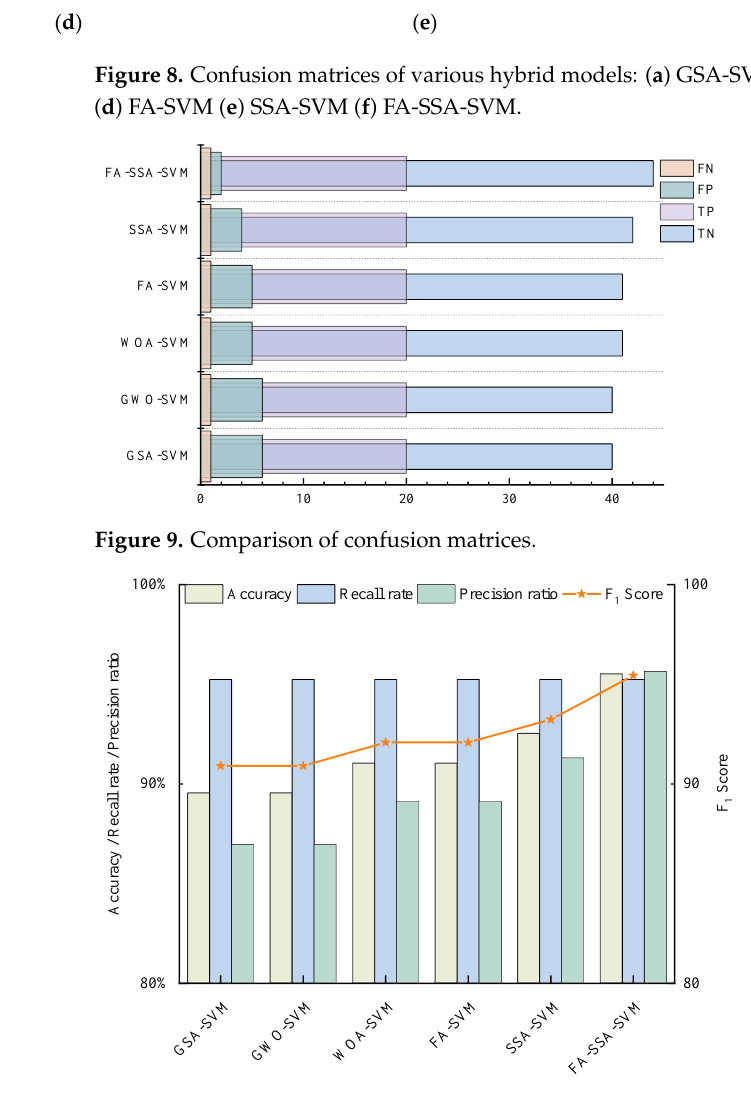
Figure 10. Comparison of evaluation indices.